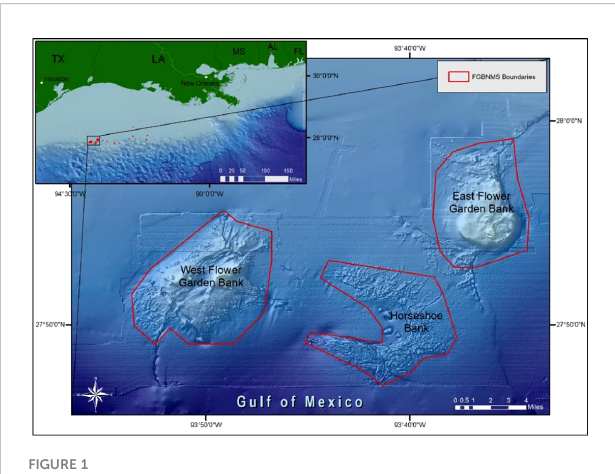
FIGURE 1 The Flower Garden Banks National Marine Sanctuary (northwest Gulf of Mexico) consists of 17 reefs and banks off the coasts of Texas and Louisiana (inset). East and West FGB boundaries are outlined in